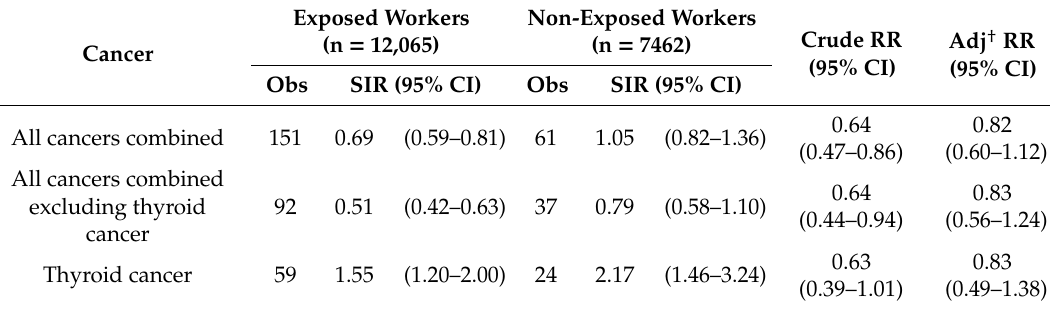
Table 6. Relative risks of cancer between the exposed and non-exposed groups ( ≤ 0.1 mSv).